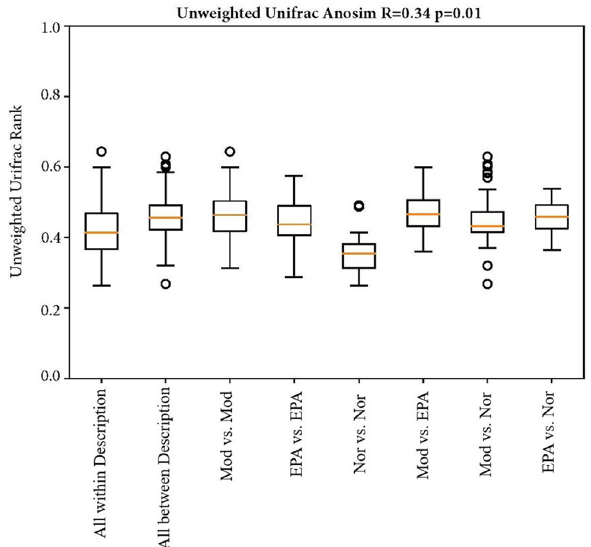
Figure 11. Anosim analysis of gut microbiota based on unweighted unifrac distance.